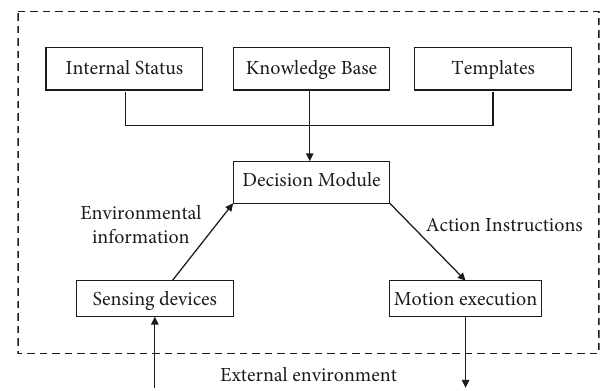
Figure 4: Structure of deliberative intelligence